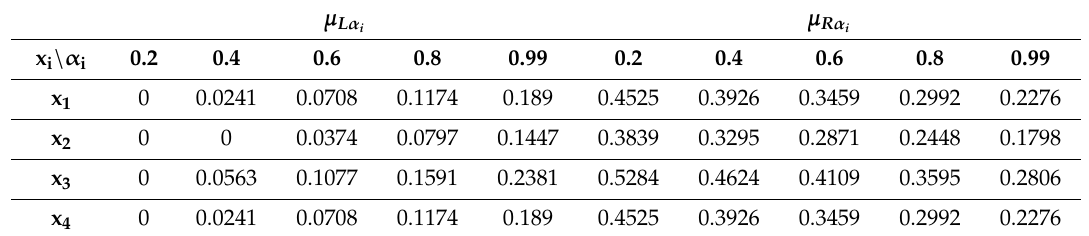
Table 5. Min values generated of the information sources with respect to the fuzzy